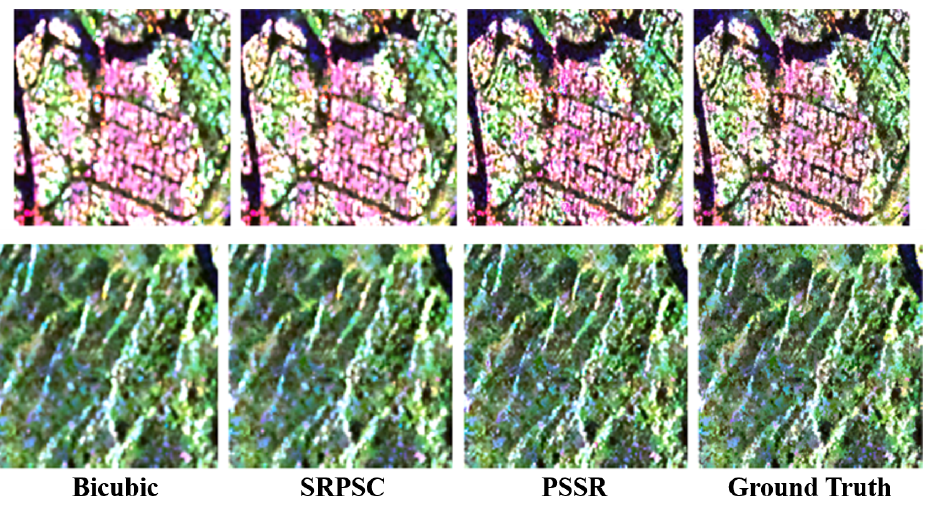
Figure 18. PolSAR image super-resolution performance comparison (Bicubic [242], SRPSC [243], PSSR: the proposed) for the urban and the forest in San Francisco